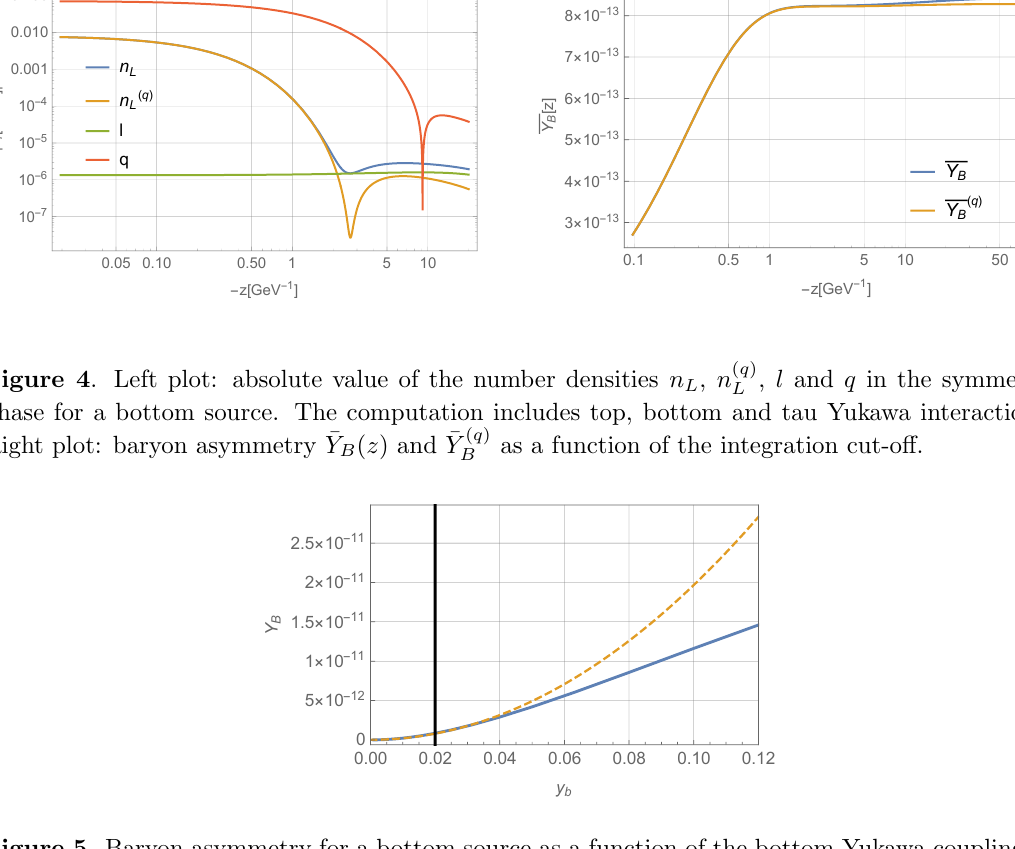
Figure 5 . Baryon asymmetry for a bottom source as a function of the bottom Yukawa coupling y b (solid blue line). The orange dashed line shows a quadratic (cid:12)t and the black vertical line indicates the SM value of y b at the electroweak